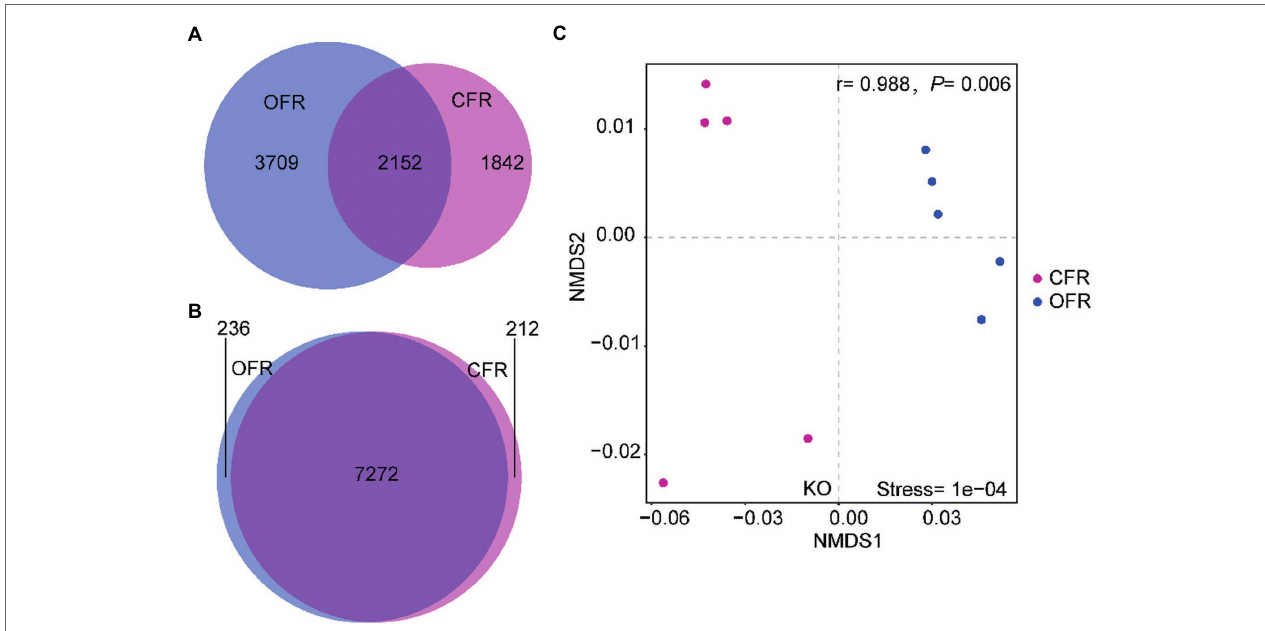
FIGURE 4 | Shifts in rhizosphere functional traits in response to different fertilization management practices. (A) Overlap of operational taxonomic units (OTUs) in rhizosphere soil; (B) Overlap of functional KOs in rhizosphere soil; and (C) Nonmetric multidimensional scaling (NMDS) ordinations of functional genes based on Bray–Curtis distance matrices of